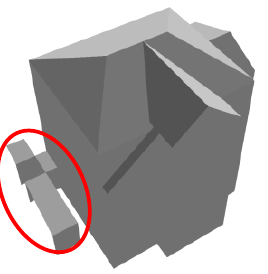
Figure 12. Reconstructed building in Figure 8d without considering the regularization term in Equation 1.